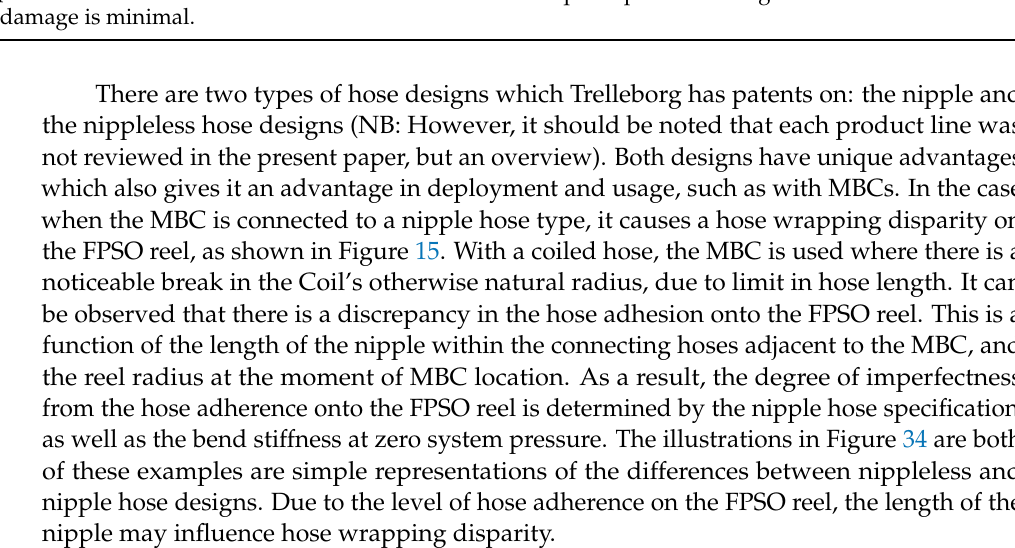
Table 10. Hose selection for different configurations (based on author’s research